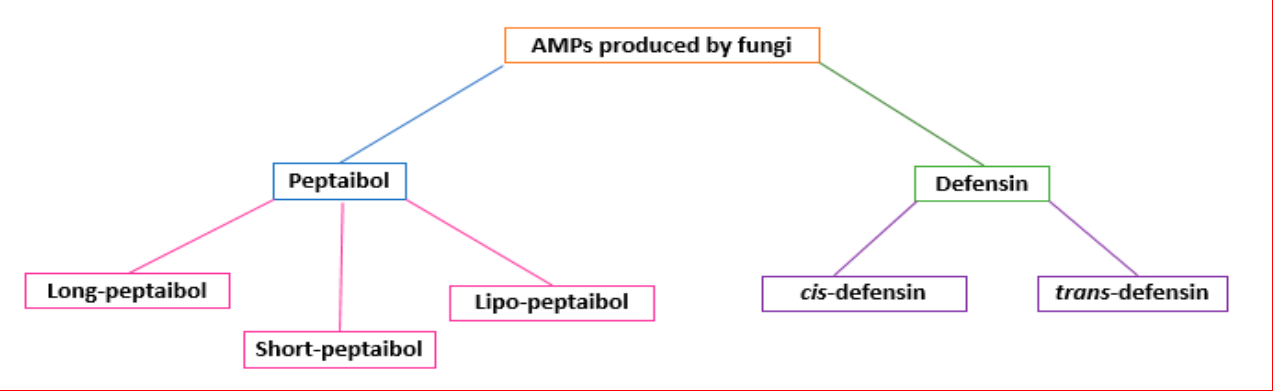
Figure 4. Classification of the AMPs produced by fungi.